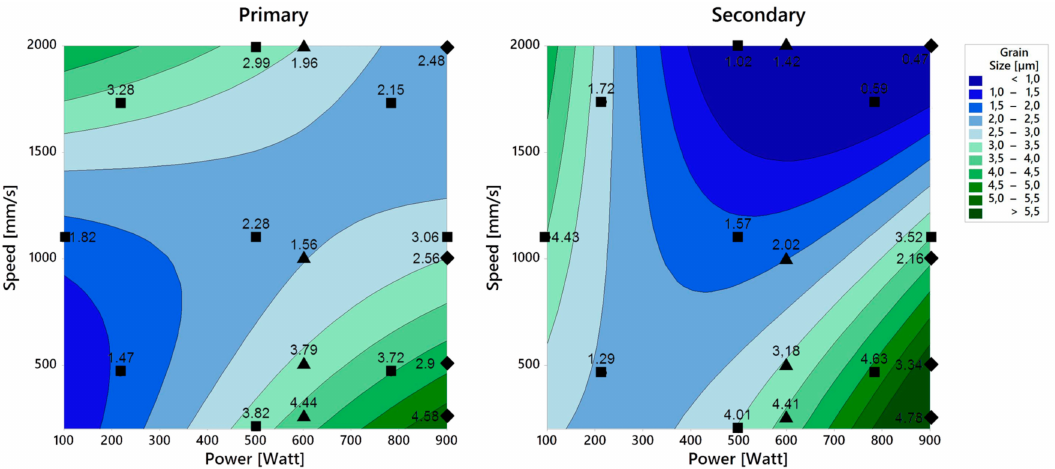
Figure 8. Grain length of Al phase for primary and secondary laser tracks . Topographical representation based on the regression data.